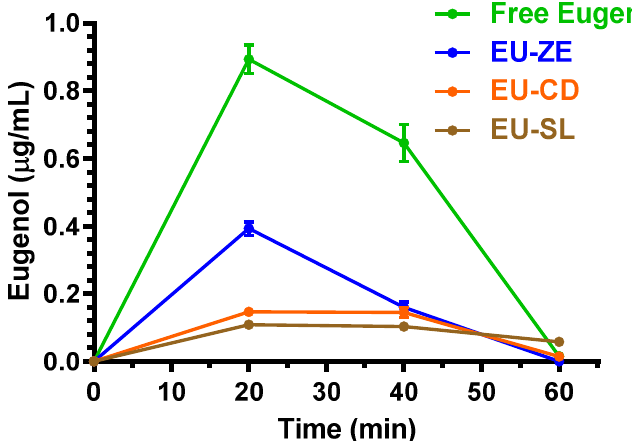
Figure 7. CSF eugenol concentrations ( µ g/mL) within 60 min after oral administration of 500 mg/kg doses to rats. Data are expressed as the mean ± SE of four independent experiments. The oral formulations consisted of dissolved eugenol in corn oil (free eugenol), or eugenol adsorbed in vegetal fibers (EU-GN) or complexed with cyclodextrins (EU-CD) or included with soy lecithin (EU-SL).